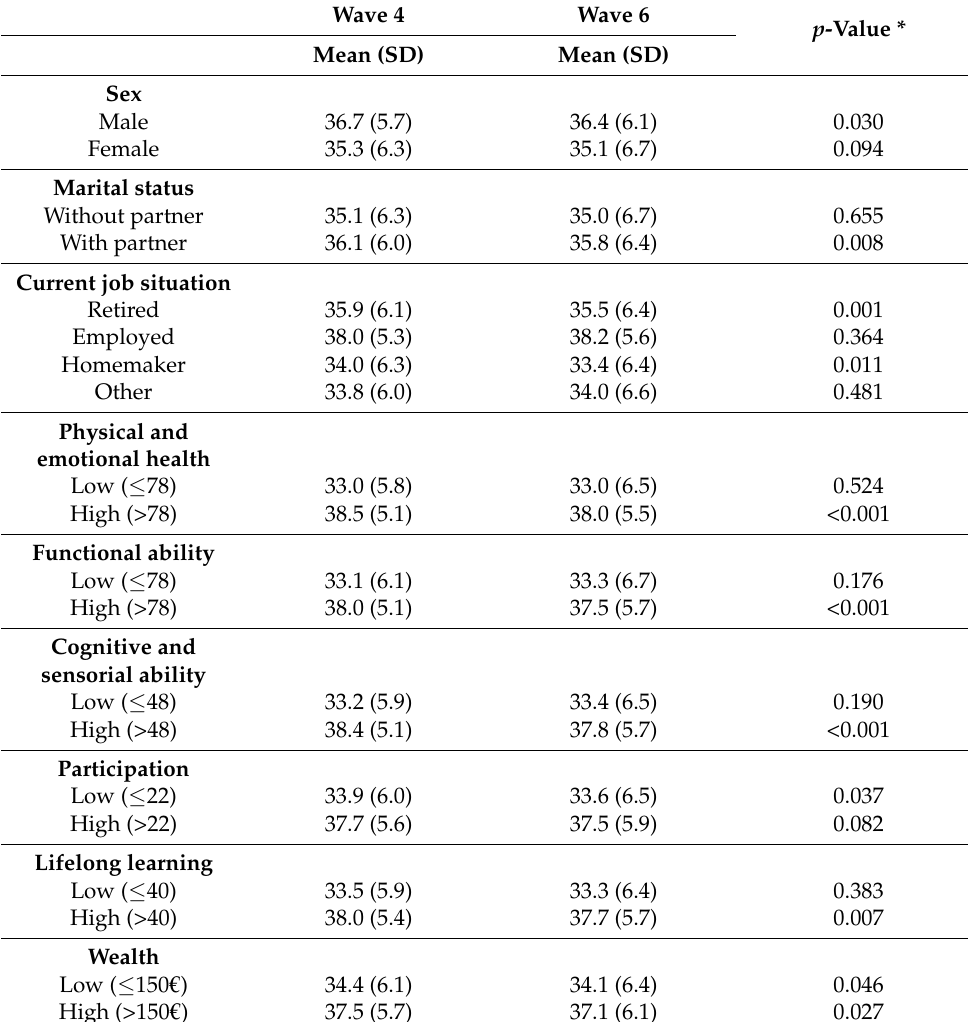
Table 3. Means and standard QoL deviations (CASP-12) by explanatory variables for each wave (imputed